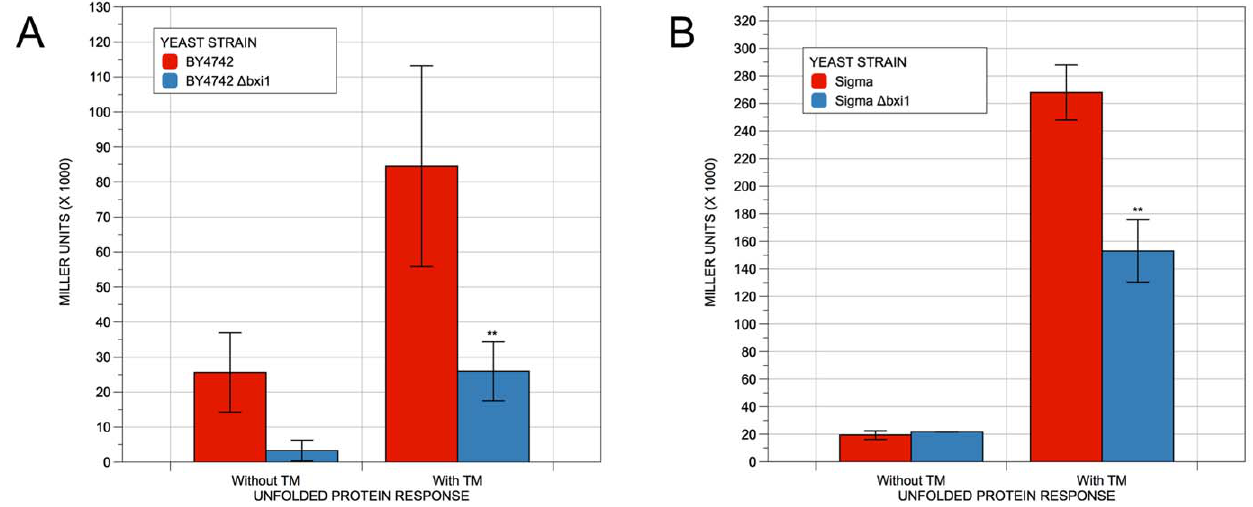
Figure 6. Deleting BXI1 diminishes the unfolded protein response induced by tunicamycin. Cells of the indicated genotype were transformed with a UPR-lacZ reporter, grown overnight in selective media at 30 u C. They were then resuspended in fresh media and allowed to reach exponential phase (an approximate OD 600 value of 0.4). Next, they were resuspended in fresh media or in fresh media containing 0.6 m g/ml TM and allowed to grow at 30 u C for three hours. b -galactosidase assays with the colorimetric substrate o -nitrophenyl- b -D-galactopyranoside (ONPG) were then performed using the permeabilized cell method and quantified as previously described. [37,41,42] The differences in b -galactosidase levels were deemed statistically significant by the Student’s t-test (p , 0.05). Error bars indicate standard deviations for trials with at least three independent transformants.